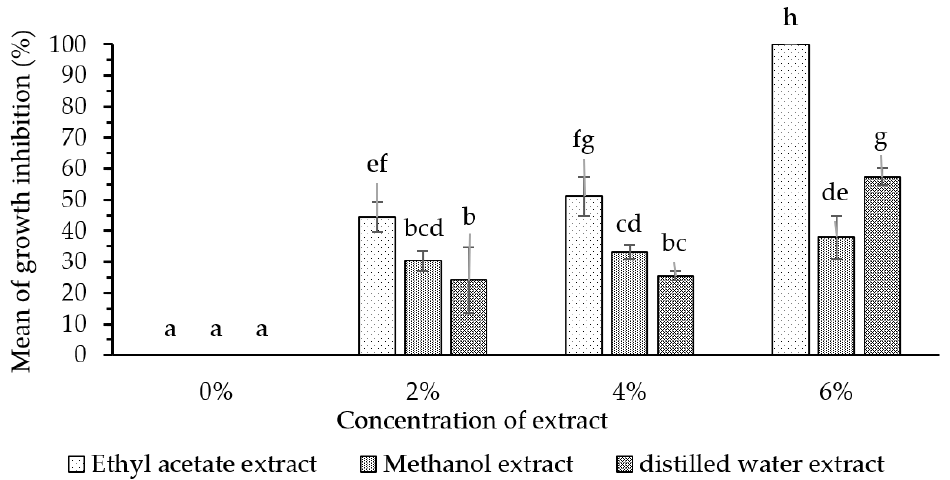
Figure 2. Mean of growth inhibition of the ethyl acetate, methanol, and water extracts, with concen- trations of 0% (control solution), 2%, 4%, and 6% on the growth of A. foetidus fungus. Notes: the same letter on the statistic bar indicates no significant difference ( p < 0.05).